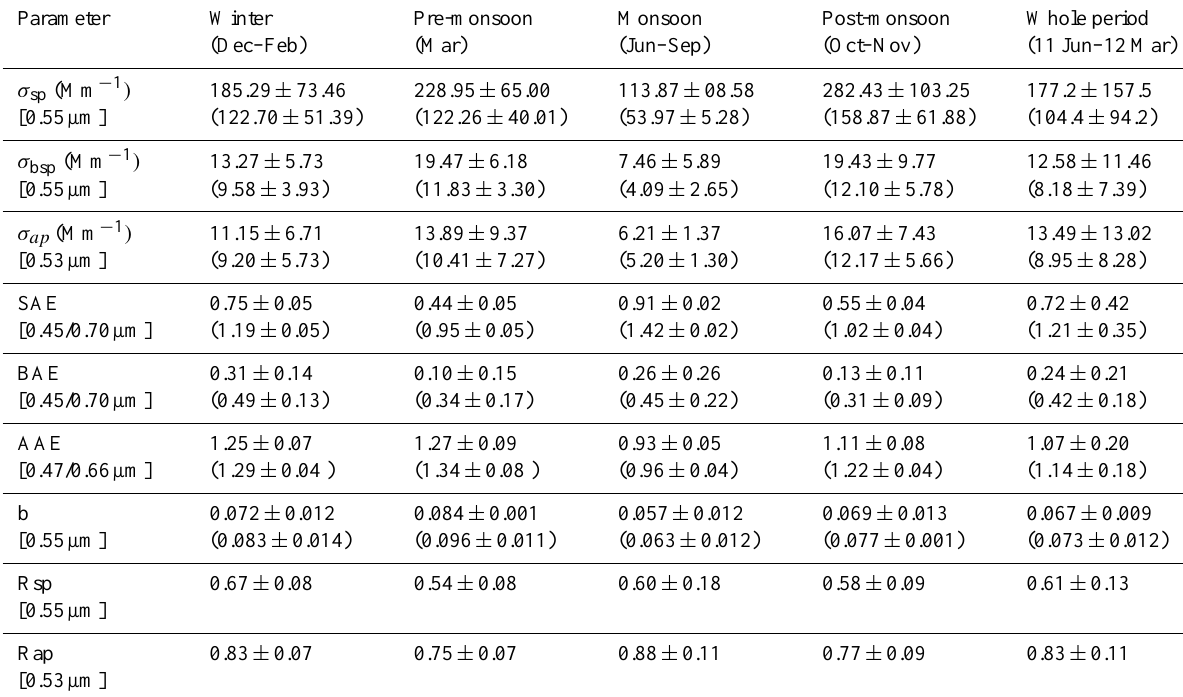
Table 2. Summary of the extensive and intensive aerosol properties during the GVAX campaign (June 2011–March 2012). The values in parenthesis refer to the D 1µm